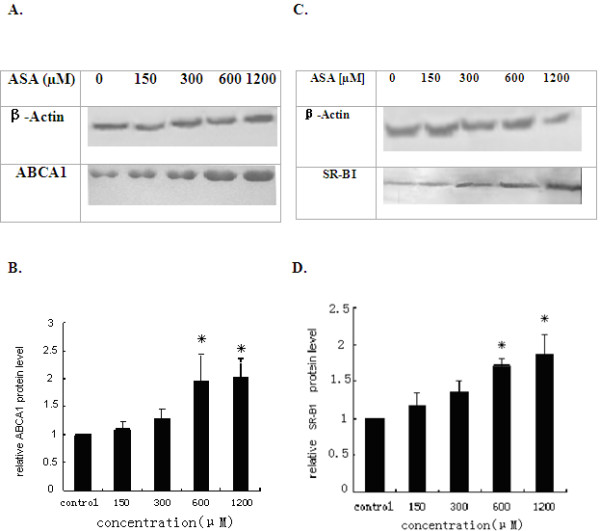
Increases in the protein levels for ABCA1 and SR-BI from the conditioned media by ASA. THP-1 macrophages were cultured in 1 media containing 10% FBS with ASA for 24 h. The total proteins from culture supernatants of THP-1 cells were separated by SDS-PAGE. SR-BI (A, B) and ABCA1 (C, D) protein levels were determined by Western blot analysis with specific antibodies (A, C). The signal intensities from blots were qualified by the Quantity One software and transformed to the bar graphs (B, D). Results are expressed as mean ±S.D, of three experiments with duplicated samples. * P <0.05,compared to control(Figure 7B, D).